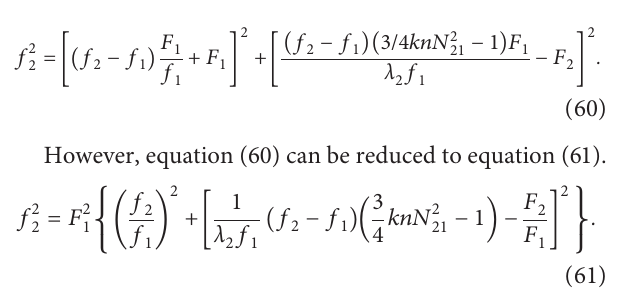
of different nonlinear stiffness kn ( λ 2